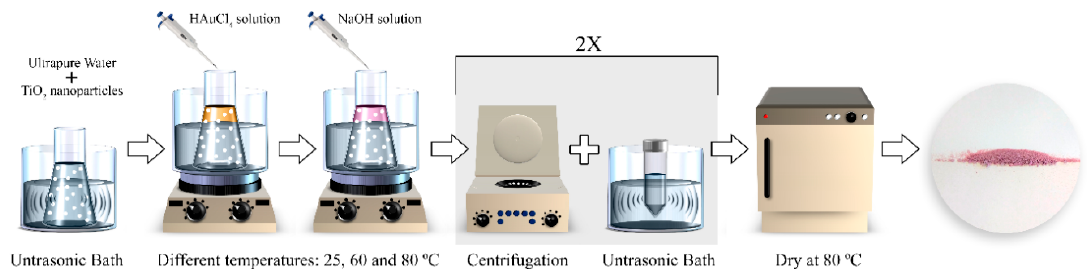
Figure 10. Schematic representation of the main steps to synthesize Au / TiO 2 nanocomposites trough nanoprecipitation.